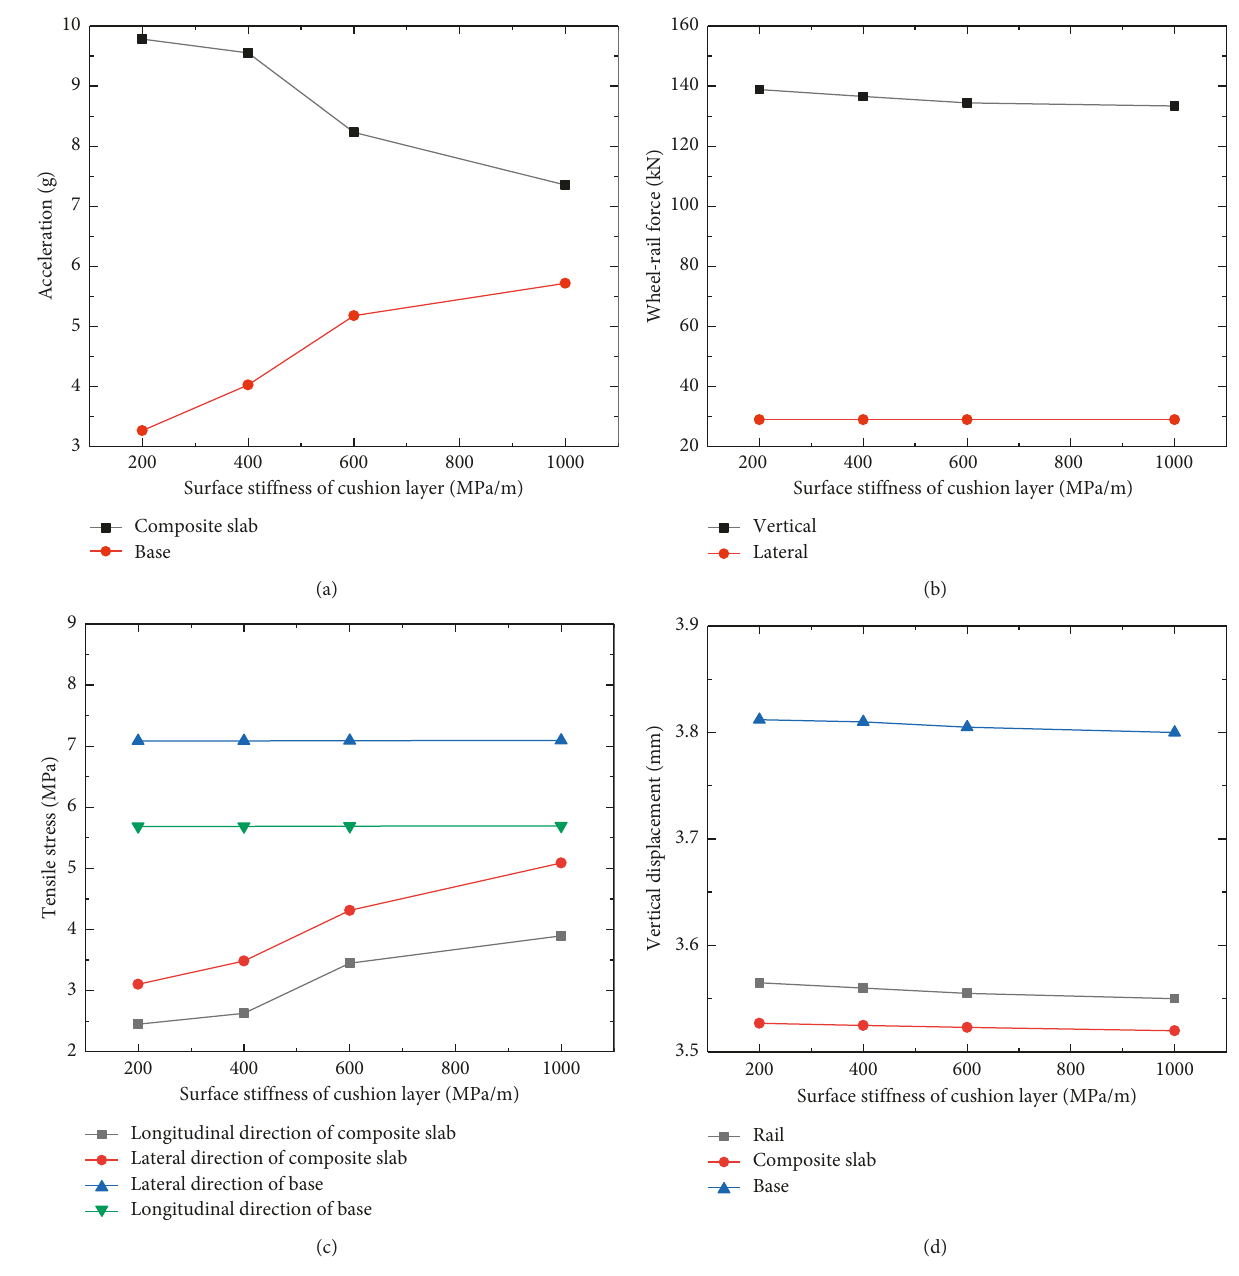
Figure 5: The maxima of the dynamic responses of the vehicle-track system with different surface stiffnesses of cushion layer. (a) The vertical accelerations of composite slab and base. (b) The wheel-rail force. (c) The tensile stress of composite slab and base. (d) The vertical displacement of rail, composite slab, and